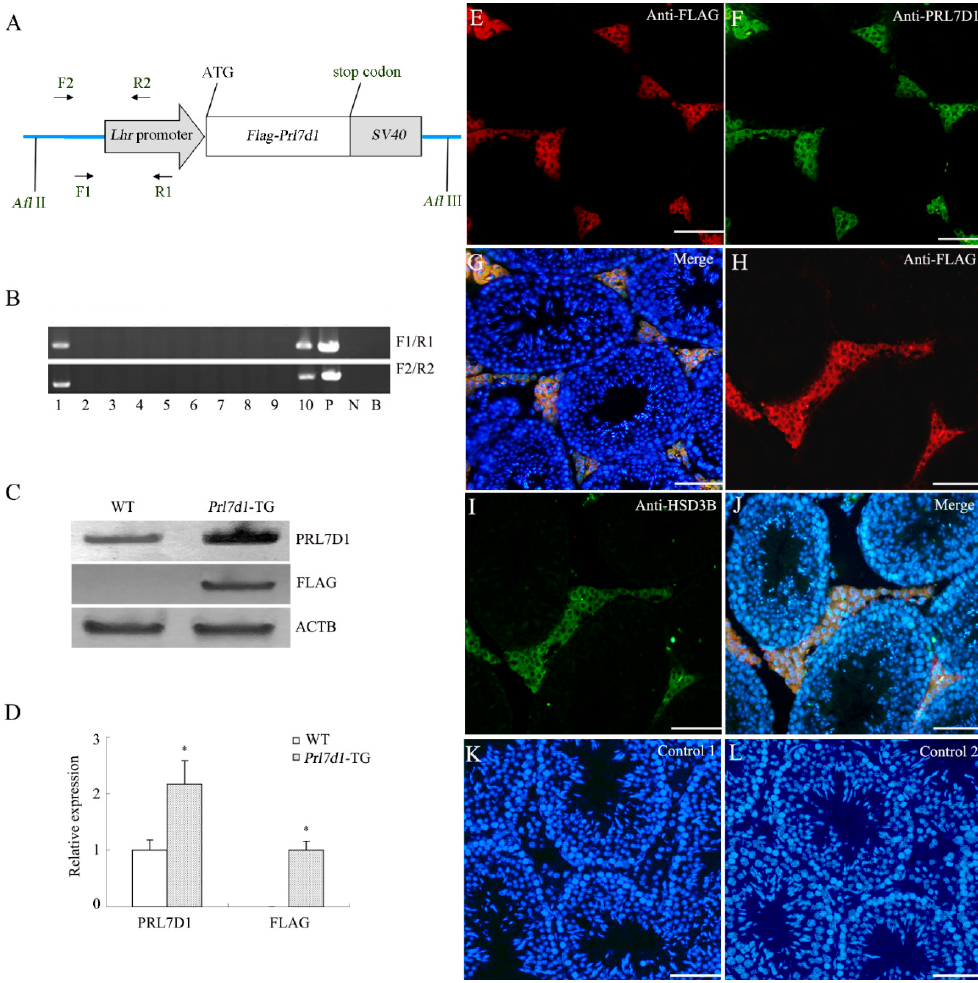
Figure 1. Generation of transgenic mice overexpressing Prl7d1 . ( A ) Schematic representation of the Prl7d1 transgenic construct. The Lhr promoter was fused to Flag -tagged mouse Prl7d1 cDNA and SV40 polyadenylase signal. The FLAG epitope (DYKDDDDK) was introduced into the amino-terminus of the PRL7D1 protein. The primers used for the detection of the transgene are indicated by arrows; ( B ) PCR analysis of the genomic integration of the mouse Prl7d1 transgene. N, negative control; P, positive control ( Prl7d1 transgenic construct); B, blank control; ( C ) Western blot analyses of PRL7D1, FLAG and actin beta (ACTB) in the testes of four-month-old Prl7d1 transgenic ( Prl7d1 -TG) and wild-type (WT) mice; ( D ) The relative expression of PRL7D1 and the FLAG-tagged protein in the testes of mice are shown following their normalization against ACTB. Data are expressed as the means ˘ SD ( n = 6). The protein level within the WT group was set to one. * p < 0.01 compared to the WT group; ( E – L ) Double immunofluorescence staining revealed that FLAG-tagged protein (red fluorescence) co-localized with PRL7D1 (green fluorescence) ( E – G ) or HSD3B (green fluorescence) ( H – J ) in Leydig cells of adult Prl7d1 mouse testes. Control 1: testicular tissue sections were incubated with IgG1; Control 2: immunofluorescent staining of FLAG-tagged protein in WT testis sections. There was no positive staining in Leydig cells. Staining with DAPI (blue fluorescence) was used to label the nuclei of individual cells found in the section. The scale bar is 50 µ